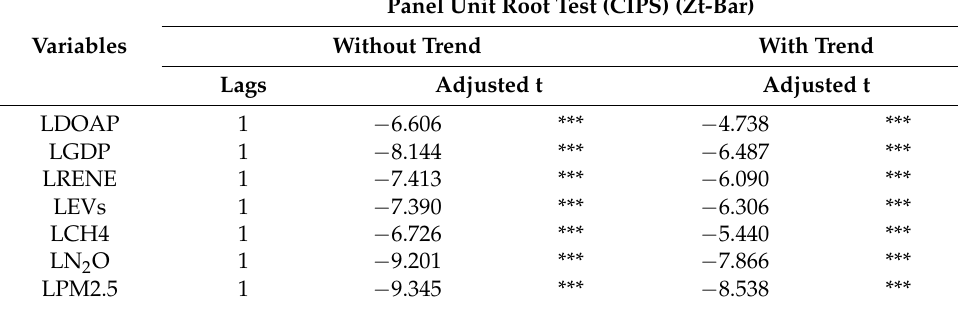
Table 7. Panel unit root test.